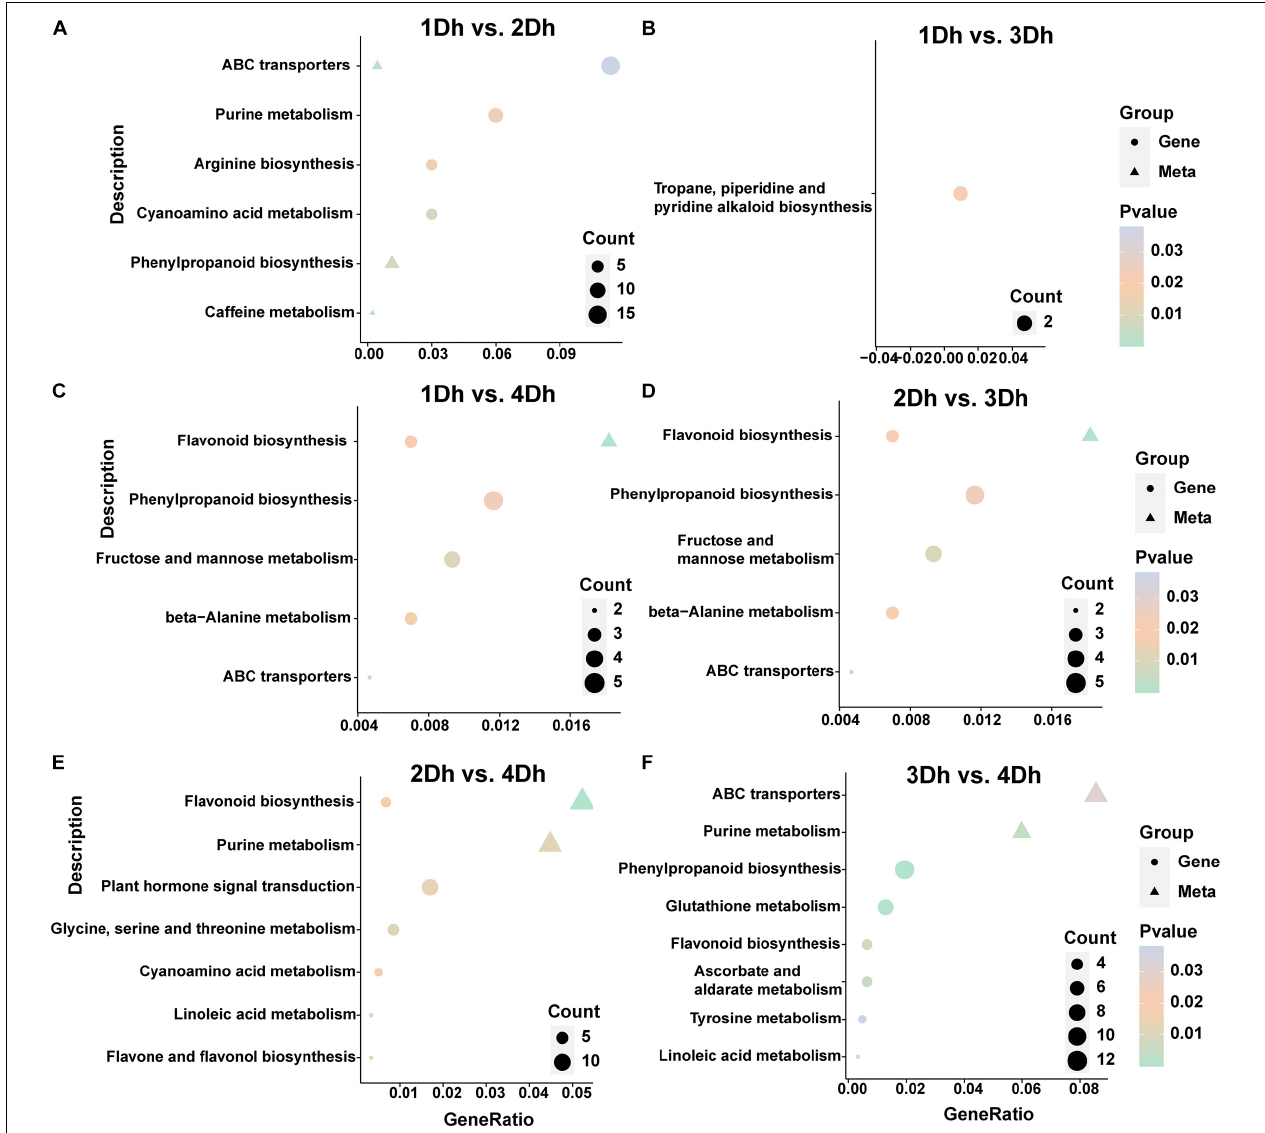
FIGURE 5 | Integrated with DEGs and DAMs of KEGG pathway. (A) 1Dh vs. 2Dh. (B) 1Dh vs. 3Dh. (C) 1Dh vs. 4Dh. (D) 2Dh vs. 3Dh. (E) 2Dh vs. 4Dh. (F) 3Dh vs. 4Dh.